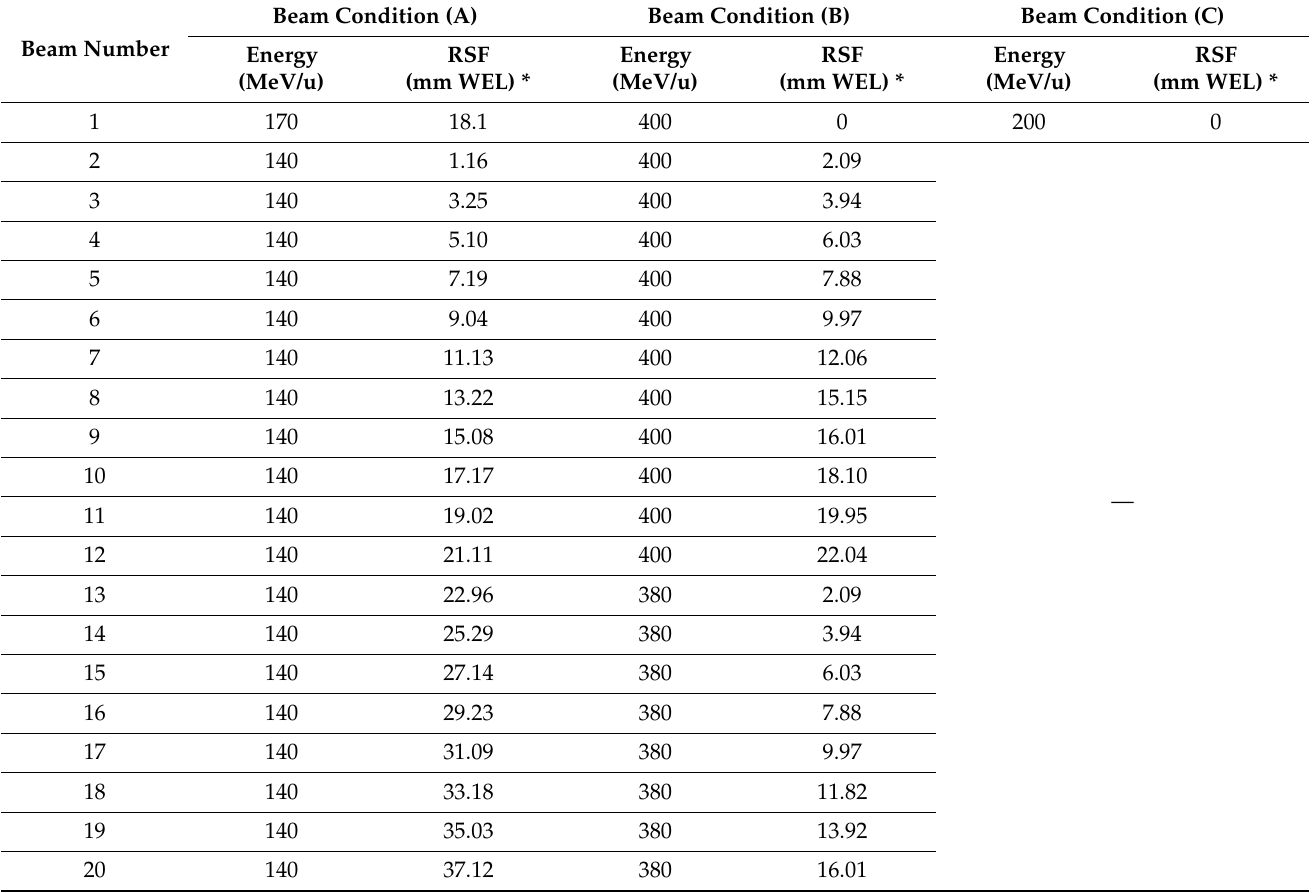
Table 3. Beam parameters used for beam conditions